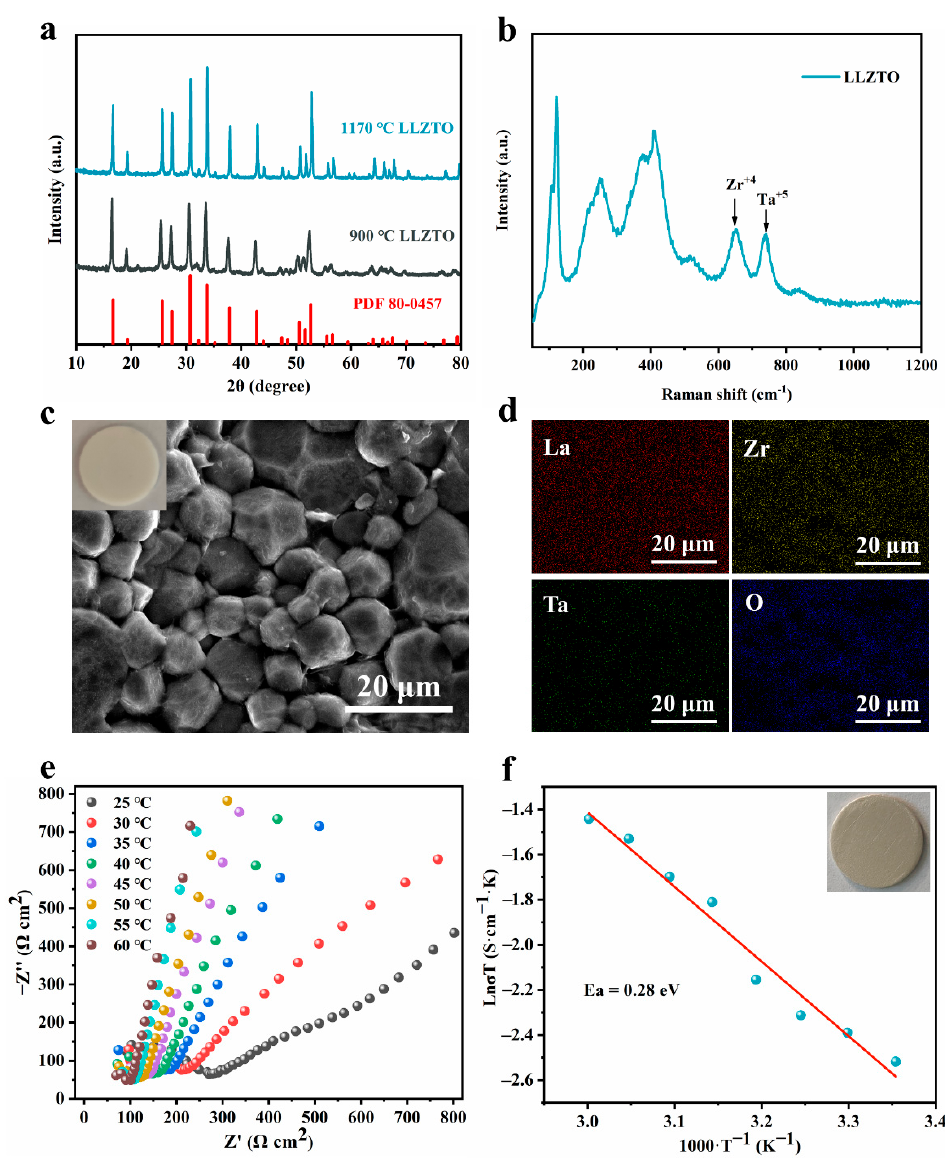
Figure 2. ( a ) The XRD pattern of the as-prepared LLZTO match the cubic structure well; ( b ) Raman spectra of the LLZTO; ( c ) cross-section SEM image of the LLZTO pellet, inset is a photo of an LLZTO pellet; ( e ) EIS profiles of the LLZTO electrolyte at different temperatures in the range 25 – 60 °C; ( f ) Arrhenius plots of the ionic conductivity for the LLZTO. Inset is a photo of Ag-LLZTO.